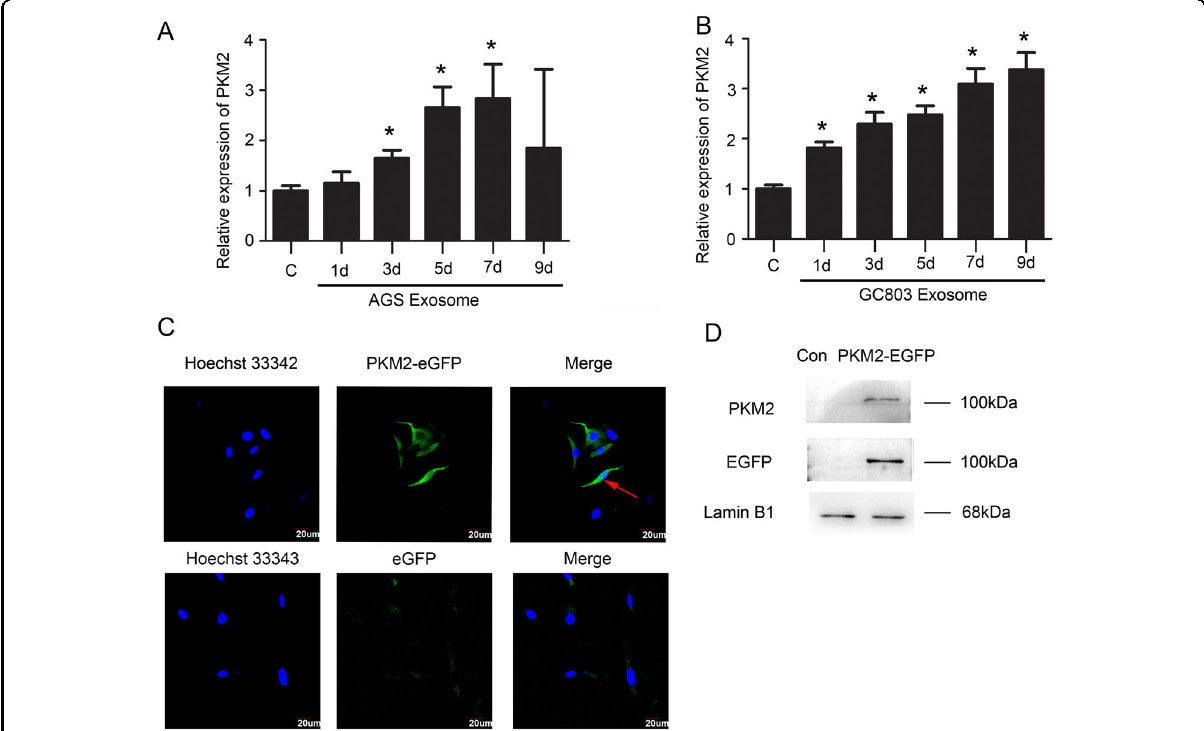
Fig. 4 Sources of upregulated PKM2 in CAFs. A , B Quantitative PCR analysis detected PKM2 expression during the differentiation of MSCs into CAFs. * P < 0.05. C Confocal microscopy detected PKM2-eGFP protein of AGS could be recruited to the cytoplasm and nucleus of MSCs/CAFs. Blue: Nucleus (Hoechst 33342). Green: PKM2-eGFP fusion protein or EGFP-vector. D Western blot of the expression of the PKM2-eGFP fusion protein in the